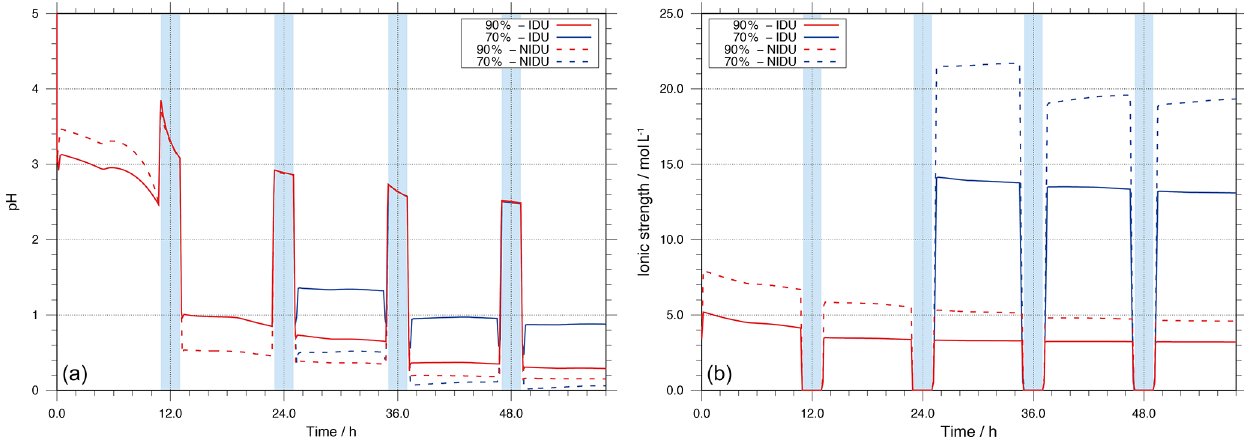
Figure 2. Modelled pH value (a) and ionic strength (I, b ) as a function of simulation time for the urban scenario for the different simulation cases (90%-IDU / 90%-NIDU and 70%-IDU /